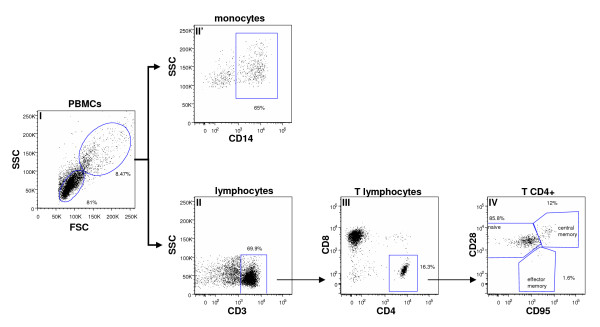
Flow cytometric sorting strategy for monocytes and T cells. A representative exemple is shown. PBMCs from each animal were stained with the antibody combination described in the material and methods. Monocytes and lymphocytes were defined with forward and side scatter (I). CD3+ T cells were then defined based on expression of CD3 (II). CD4+ T cells were then defined based on expression of CD4 without expression of CD8 (III). Naïve CD4+ T cells were then separated based on expression of CD28 without expression of CD95 (IV). Central memory CD4+T cells were then separated based on dual expression of CD28 and CD95 (IV). Effector memory CD4+ T cells were then separated based on expression of CD95 without expression of CD28 (IV). The CD14+ monocytes were separated based on expression of CD14+ (II').